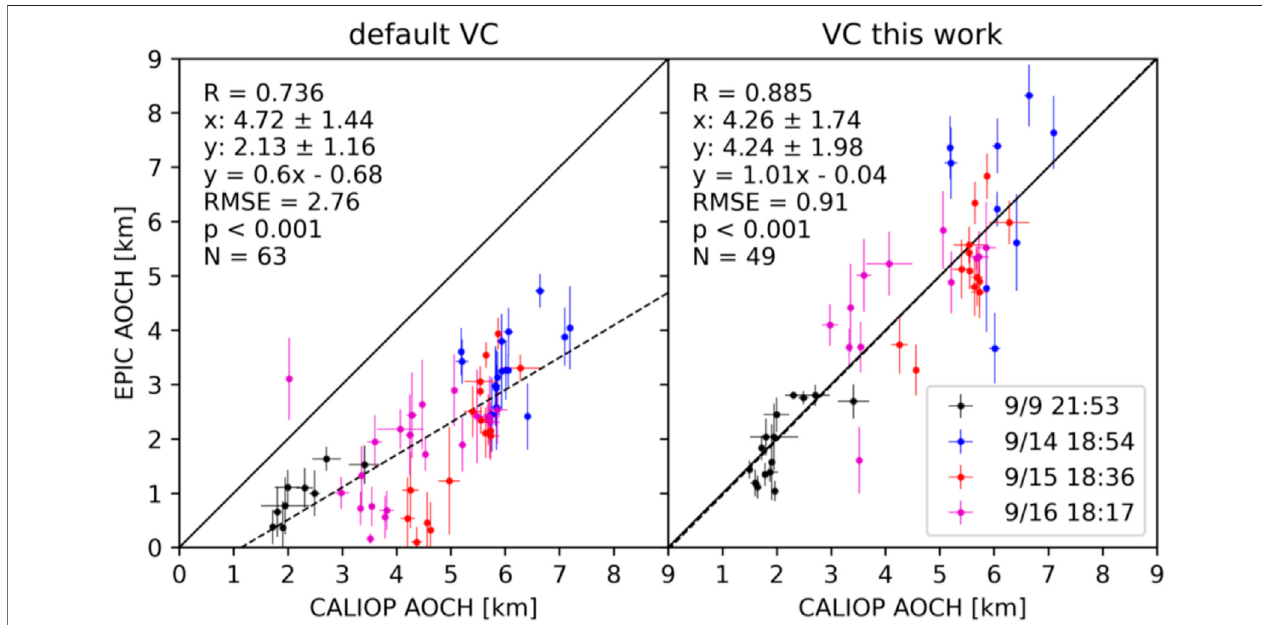
FIGURE 5 | Scatter plot of EPIC AOCH retrieval and CALIOP AOCH for September 9 and 14 – 16. The left panel shows the EPIC retrieval without the vicarious calibration, and the right panel shows that with the vicarious calibration.